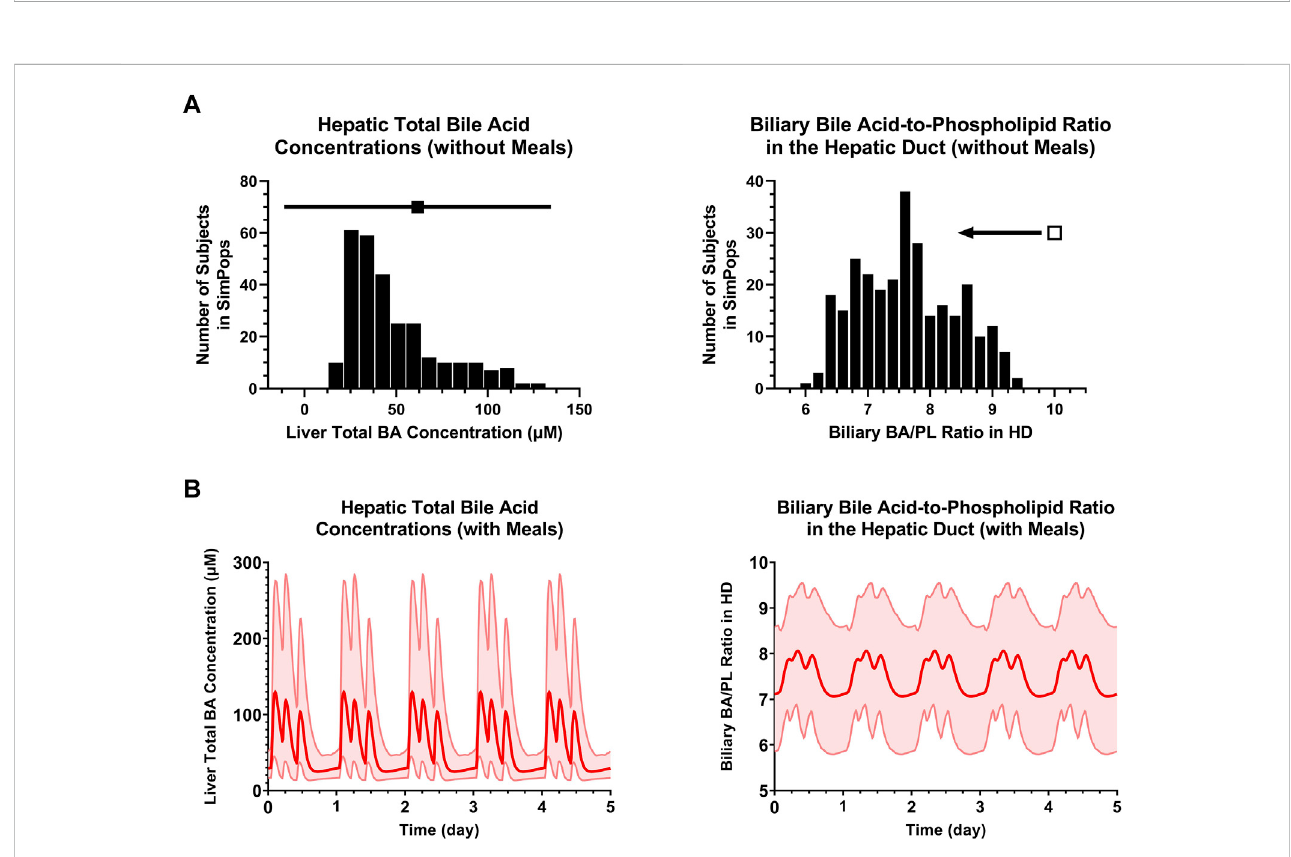
FIGURE 6 (A) SimPops distribution of liver BA concentrations and the biliary BA/PL ratio in the HD under fasted conditions. Clinically observed mean ± SD data for hepatic total BA concentrations ( n = 6) are depicted by a solid square and horizontal line, respectively. The biliary BA/PL ratio was < 10 in the SimPops, as indicated by the single open square and left pointing arrow. (B) SimPops average (red pro fi le) and 2.5 th – 97.5 th percentiles (light red shading) of liver BA concentrations and the biliary BA/PL ratio in the HD under fed conditions. BA, bile acid; HD, hepatic duct; PL,